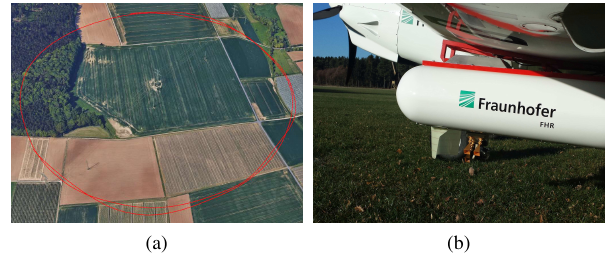
Figure 6. Airborne CSAR campaign. (a) GoogleEarth representation of circular flight trajectory with pylon in center. (b) W-band sensor below the airplane’s wing.